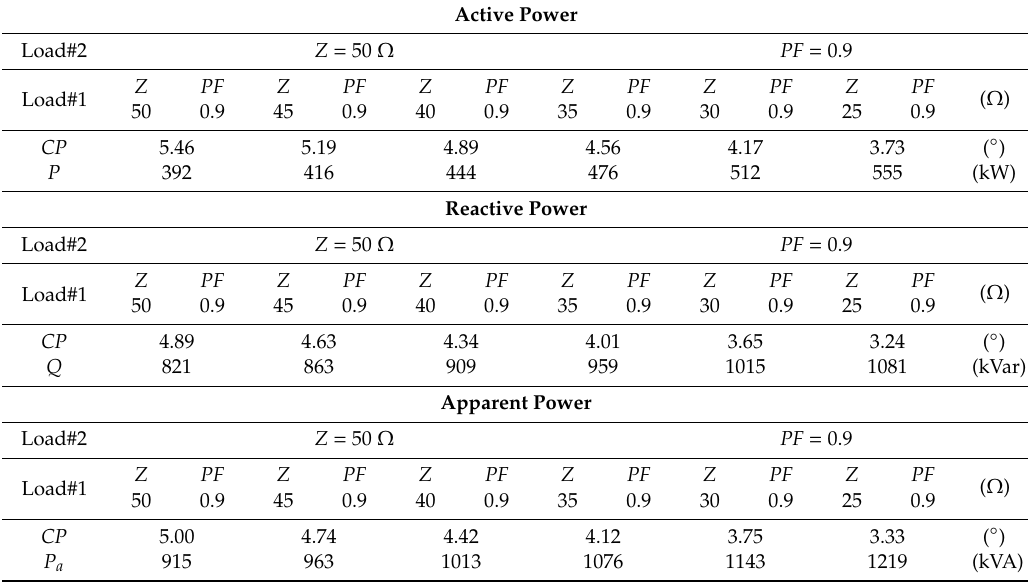
Table 1. APC (active phase controller) capacity according to load impedance change when the power factor is constant.